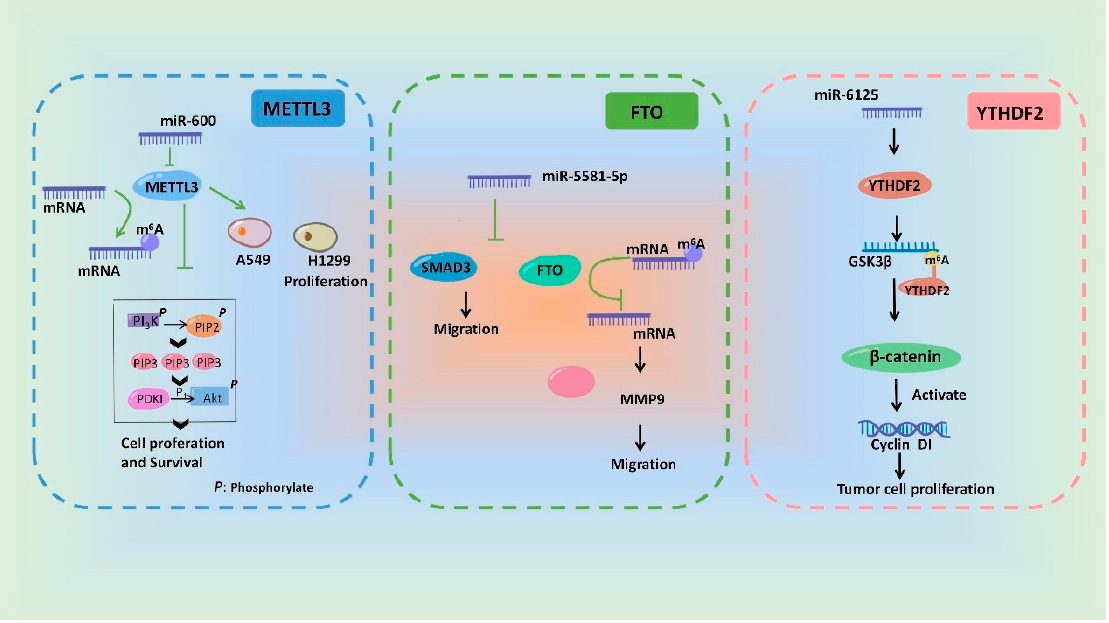
Figure 3. Schematic diagram of the mechanisms showing that m 6 A modification and its biological effects are regulated by miRNAs. Table 2. miRNAs involve in mediation the m 6 A modification.